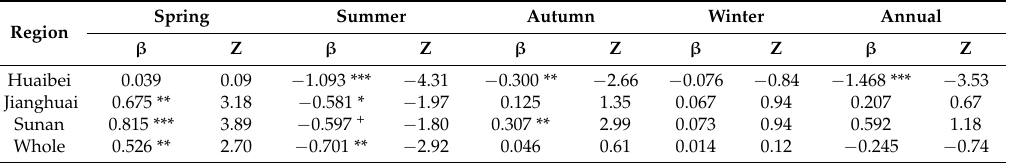
Table 2. Temporal trends for seasonal and annual ET ref (mm ∙ a − 2 ) in each region of Jiangsu province from 1961 to 2015.